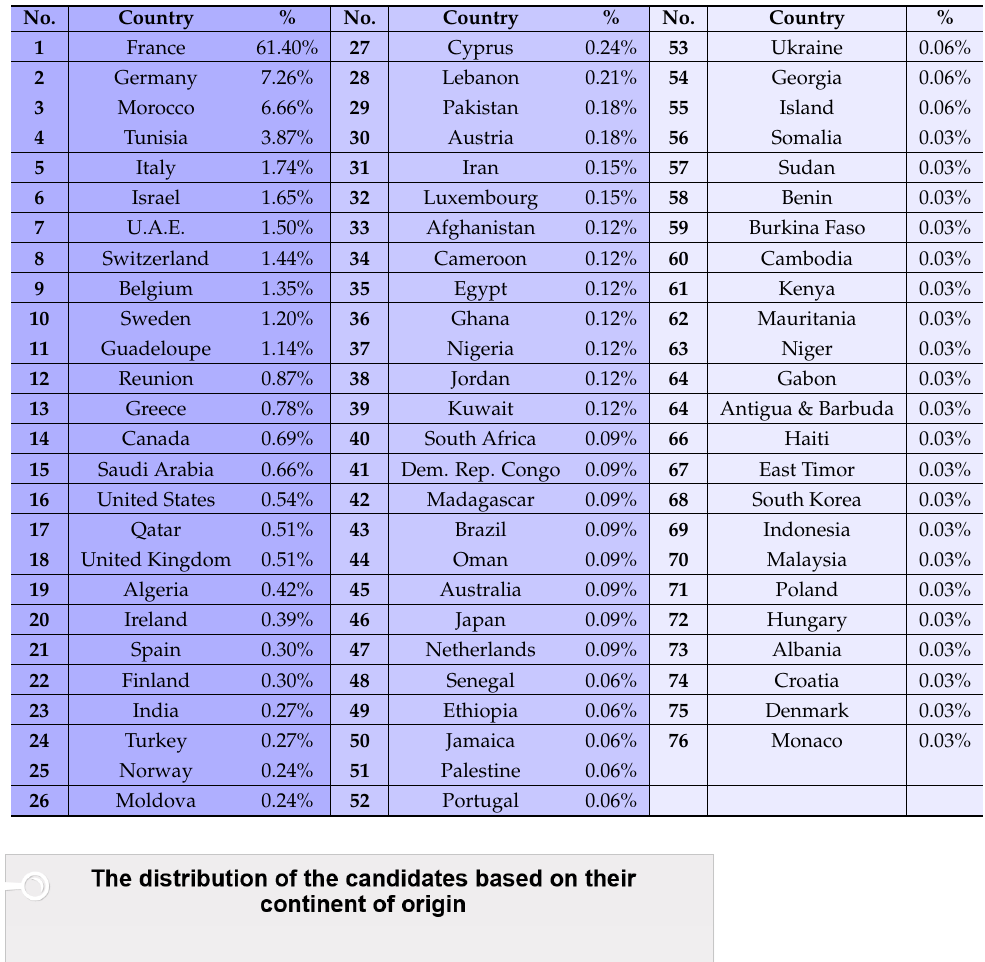
Table 4. International Candidates during the 2022 UMF Cluj International Admission.